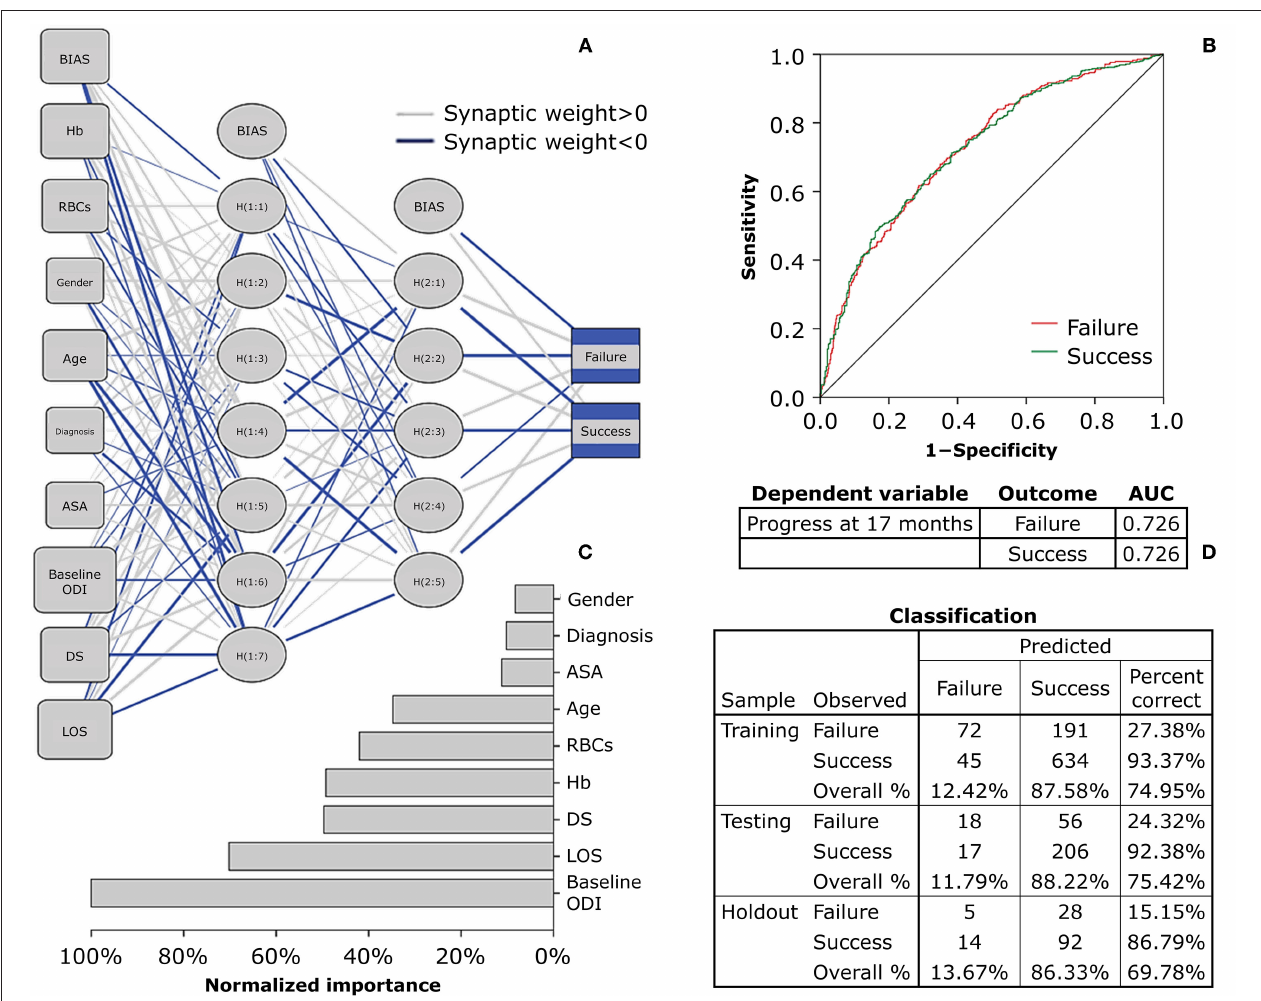
FIGURE 2 | Multiplayer perceptron network predicting 17-month clinical recovery from disability using baseline biochemical, demographic, and clinical parameters. The Multilayer Perceptron Network (MPN) shows the prediction of 17-month recovery set as a raw decrease of 12.7 points from baseline ODI. (A) The architecture has two hidden layers, with the Sigmoid and Softmax being the hidden and output functions, respectively (criteria training = batch; optimization = scaled conjugate). (B) The network ROC curve (Receiver Operating Characteristic) shows a fair diagnostic performance of the parameters in predicting the last ODI score at 17 months after spine surgery. (C) The independent variables were rescaled (standardized) to show their normalized contribution in the model: gender (8.25%), diagnosis (10.20%), ASA (11.18%), age (34.72%), RBCs (41.95%), Hb (49.22%), DS (49.67%), LOS (70.20%), baseline ODI (100.00%). (D) The classification table of predicted vs. observed values was set with a training sample at 70%, a testing sample to track prediction at 20%, and a holdout sample to assess the final model at 10%. The final percent correct shows a high performance in predicting the clinically successful outcomes, but poor reliability to forecast negative outcomes. ODI, Oswestry Disability Index, ranging from 0 (no disability) to 100 (maximum disability); Hb, hemoglobin; RBCs, red blood cell count; ASA, American Society of Anesthesiologists physical status classification system (1, healthy; 2, mild; 3, severe; 4, life threatening; 5, moribund; 6, brain-dead); DS, duration of surgery; LOS, length of hospital